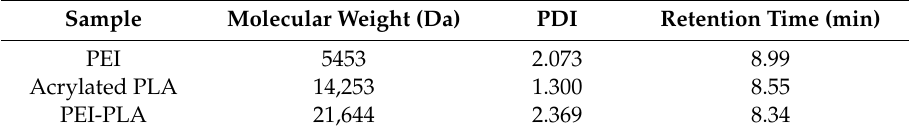
Table 1. The molecular weight, PDI and retention time of PEI, acrylated PLA and PEI-PLA copolymer as determined by GPC.